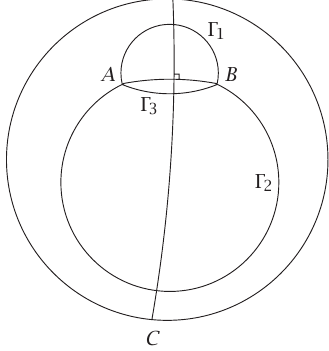
Figure 7.3 . Cutting a possible competitor to the standard double bubble in S n in which all three regions are connected and only one intersects the axis of rotation L . (Note that here L is the boundary